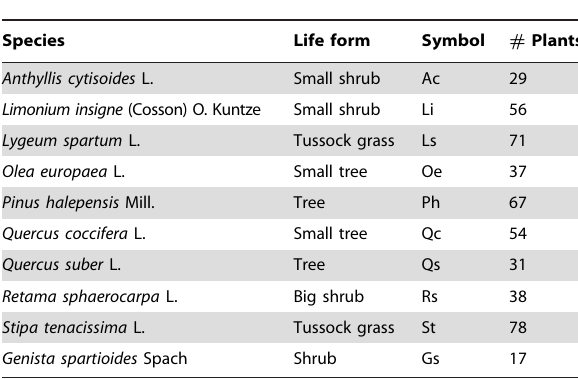
Table 1. Species used in this study, identifying symbol in figures, and number of plants used for each species. Genista spartioides was only used as a neighbour species but not as target.